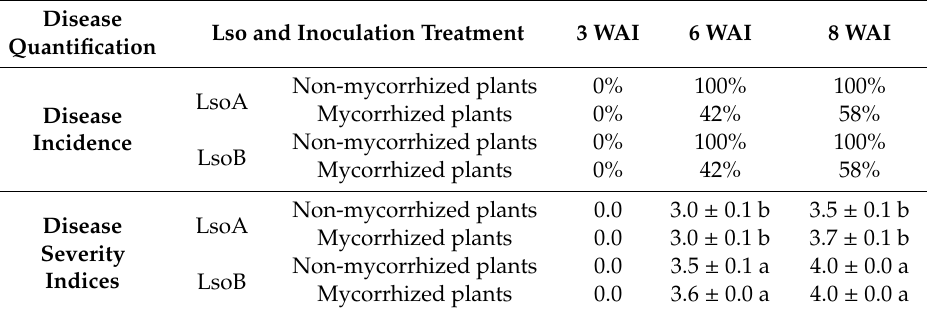
Table 2. Disease incidence and severity